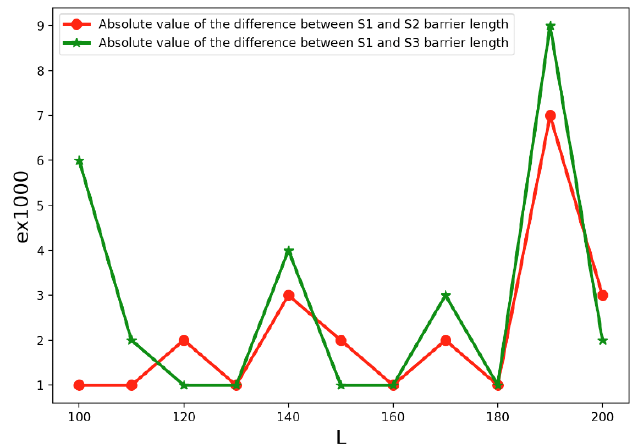
∗ . * SNR . Figure 22. The relationship between line barrier length L and optimal SNR